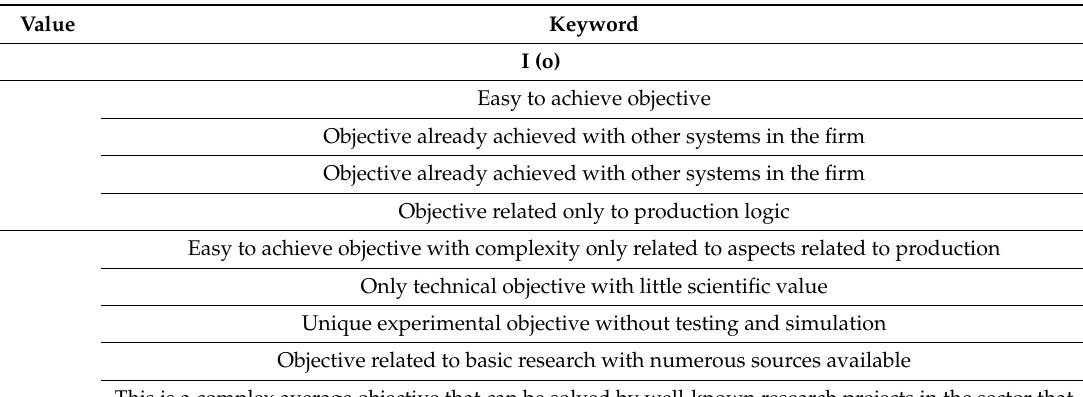
Table 2. Assessment of each level of uncertainty analysis for summary